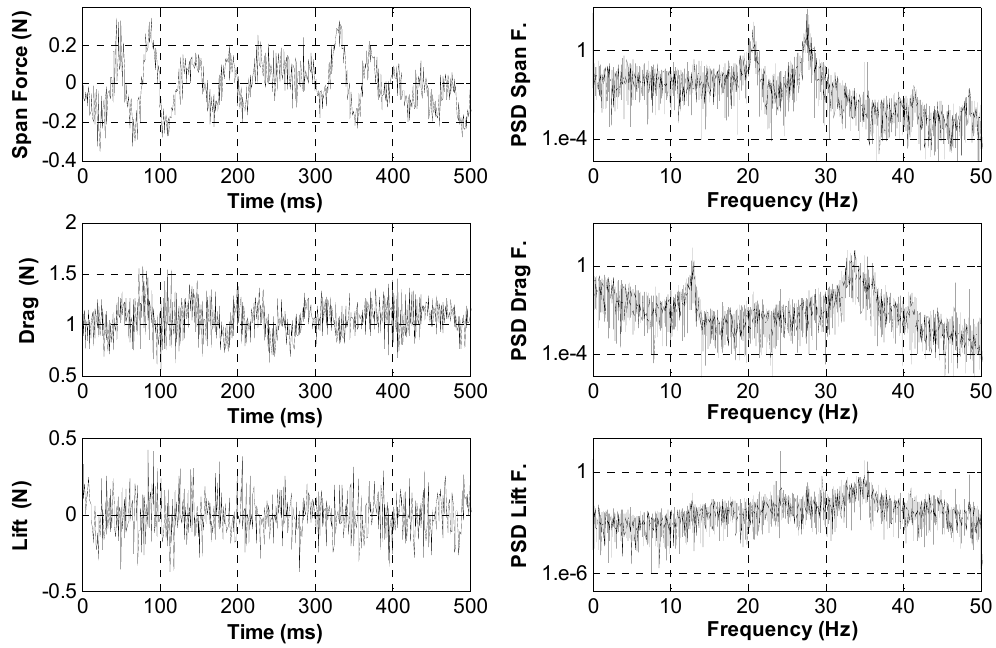
Figure 13. Time history and spectra of spanwise force, drag and lift for the normal flat